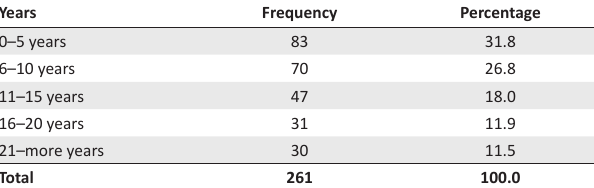
TABLE 5: Number of years respondents have worked for a